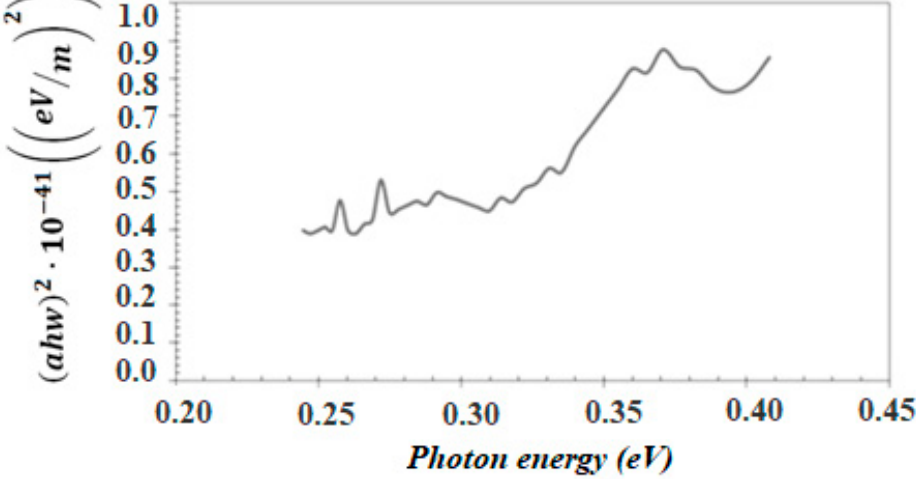
Figure 9. The plot of (ahw) 2 versus photon energy of the film thermally treated at 500 °C.